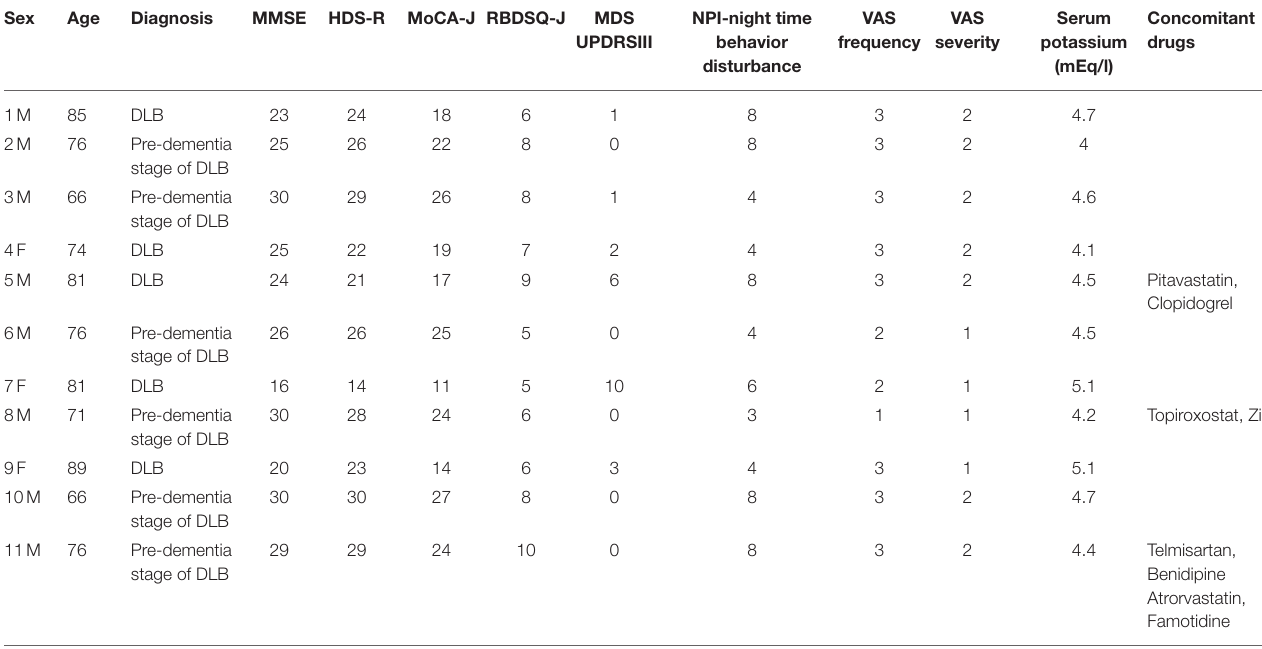
TABLE 1 | The baseline data for individual